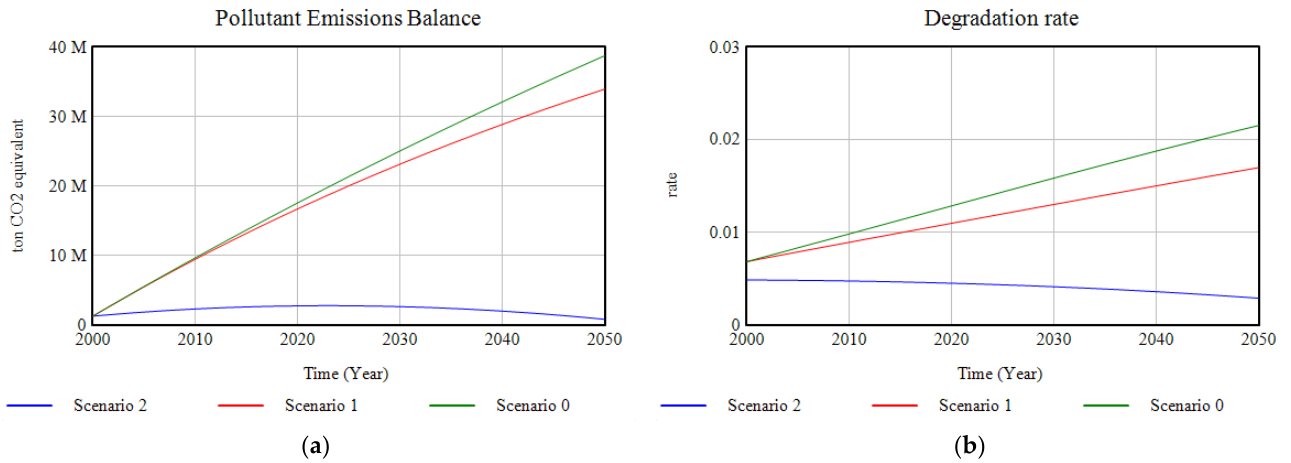
Figure 15. ( a ) Graphic results of the modelling of the pollutant emissions; ( b ) graphic results of the modelling of the ecosystems’ degradation rate, in the period 2000–2050.